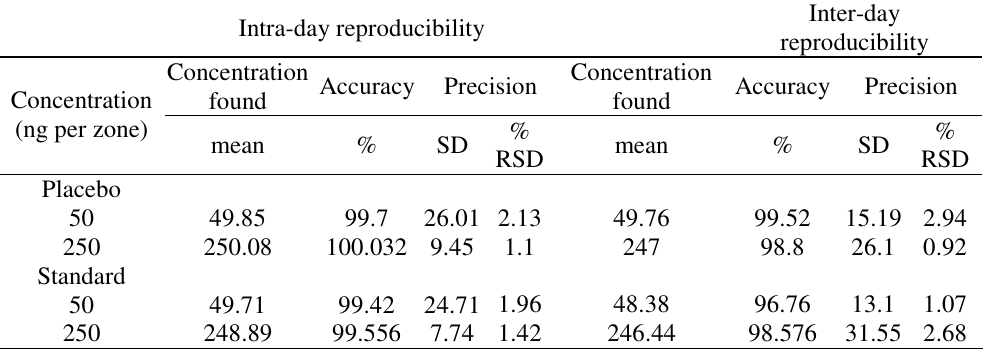
Table 2. Accuracy and precision